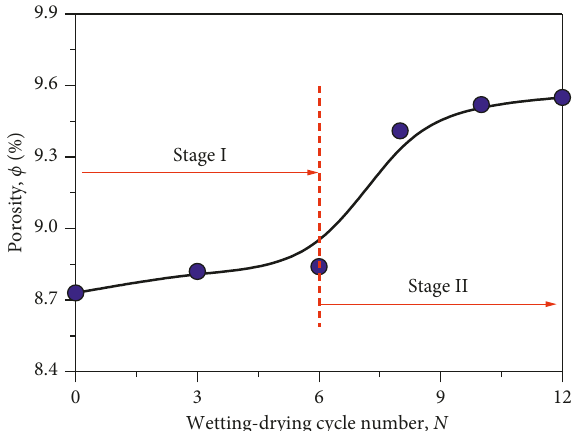
Figure 11: Variation in porosity versus the wetting-drying cycle number.